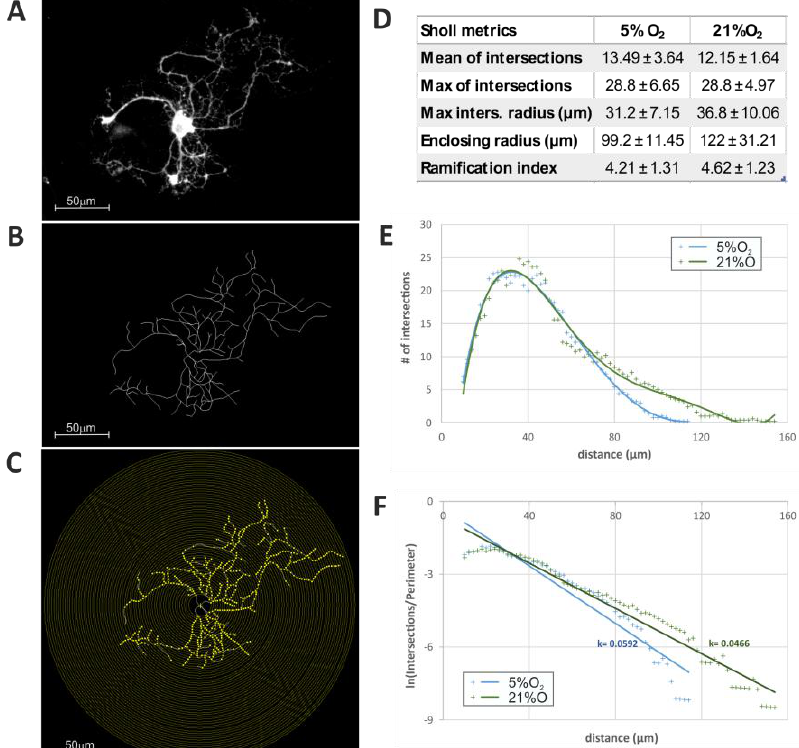
Figure 6. Evaluation of the influence of environmental oxygen concentration on oligodendrocyte (CNP + cells) differentiation, based on Sholl analysis of cell morphology on the 2nd DIV. The comparison of the length and complexity of the elaborated cell projections indicates that physiological normoxia (5% O 2 ) is permissive for the elongation of oligodendroglial processes, which is necessary for searching axons to be myelinated. ( A ) Original, 8-bit image of the cell; ( B ) Black and white masks of cells prepared by means of the NeuronJ software. A series of concentric circles around the cell bodies allowing for marking the intersections by application of the Sholl plugin to ImageJ is shown; ( C ) Concentric circles around the cell bodies drawn with Sholl plugin to Fiji; the yellow dots mark the intersections of the cell process with consecutive circles; ( D ) Sholl metrics based on samples’ data; ( E ) The linear profile presents the average number of intersections versus the distance from the cell body; ( F ) The semilog plot shows the average number of intersections normalized to the perimeter of the circles. The slope of the linear regression (Sholl’s Regression Coefficient—k) is the measure of the change in density of the branches with respect to their distance from the center.